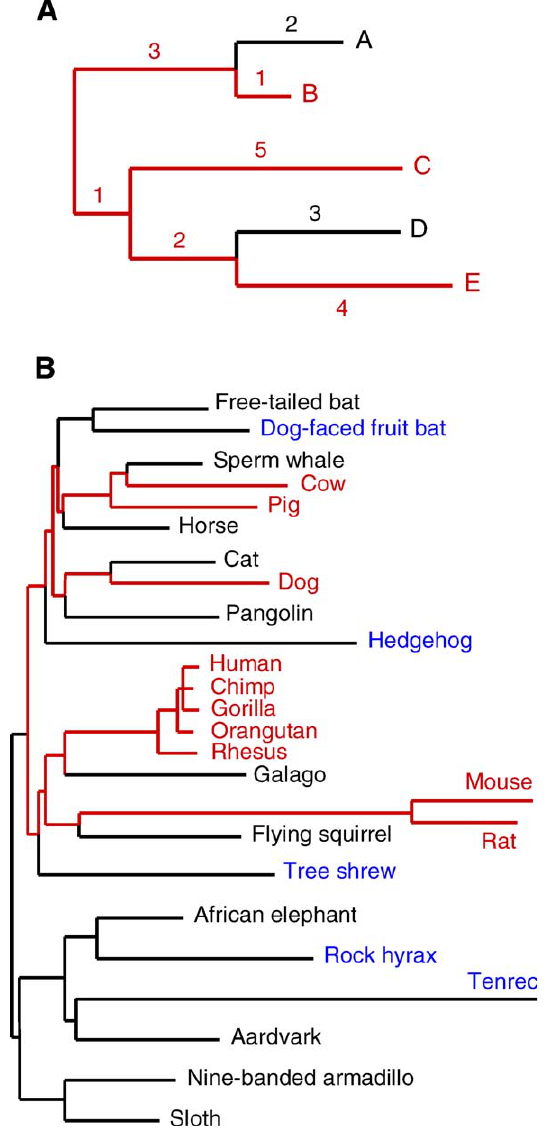
Figure 1. Phylogenetic Scopes and Divergence of Sets of